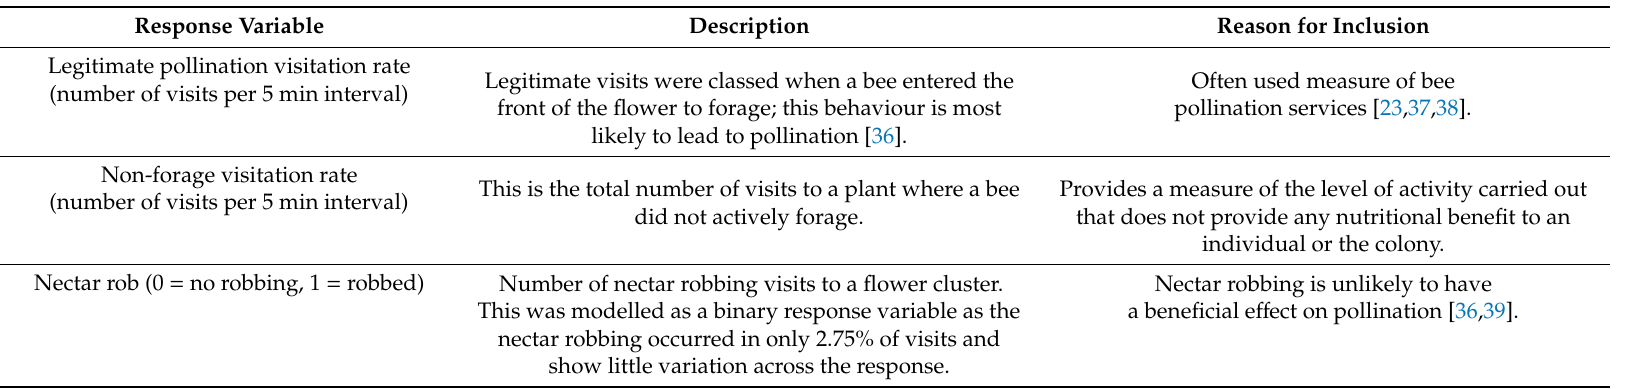
Table 1. Behavioural variables observed to determine the e ff ects of stress on Bombus terrestris foraging behaviour on Vicia faba . Colony stress treatments were Heat (25 ◦ C or 31 ◦ C) and Insecticide (40% sucrose solution or 40% sucrose solution + 5 ng g-1 w / w of clothianidin insecticide). Each level of heat treatment was crossed with each level of